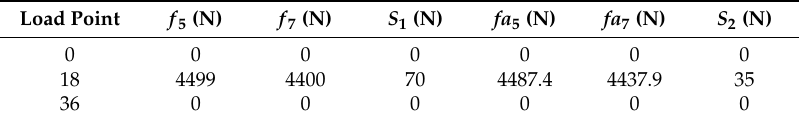
Table 6. Calculated and experimental maximum measurement module output values.